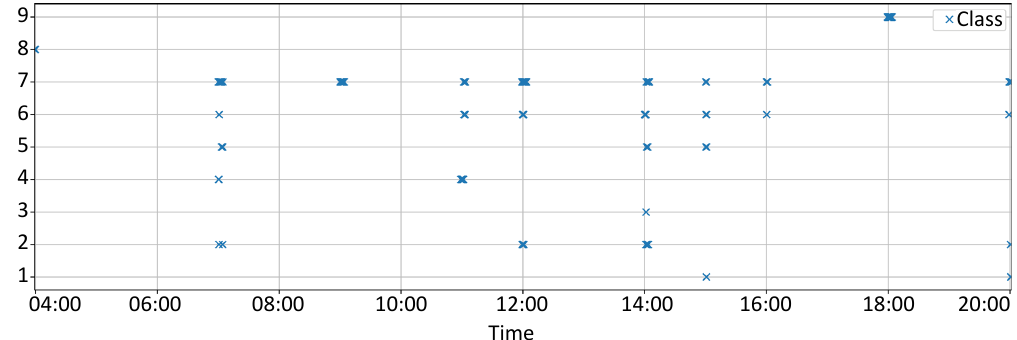
Fig. 7. Temporal distribution of the classes on a typical day (12 October 2019)